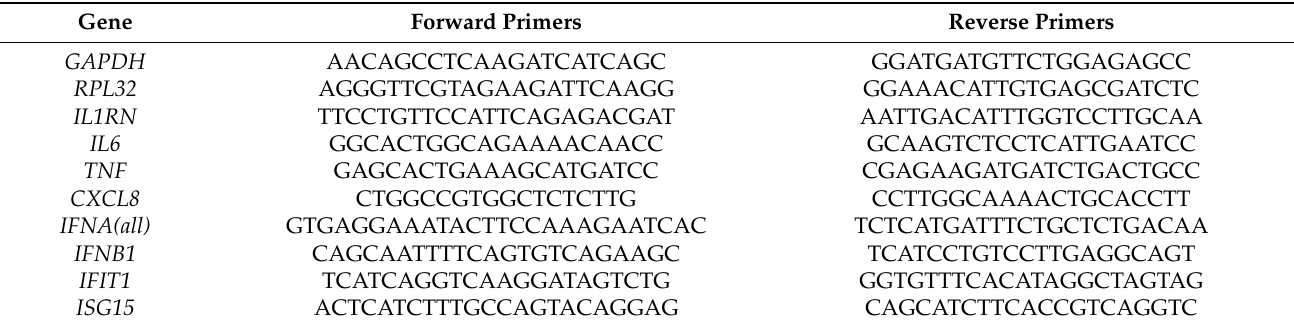
Table 1. Sequences of human gene-specific primer pairs used in